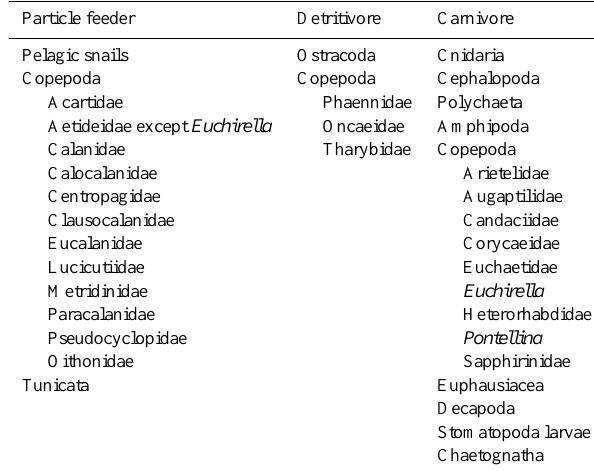
Table 5. Classification for feeding habits of zooplankton according to Lalli and Persons (1997) and Ohtsuka and Nishida (1997).